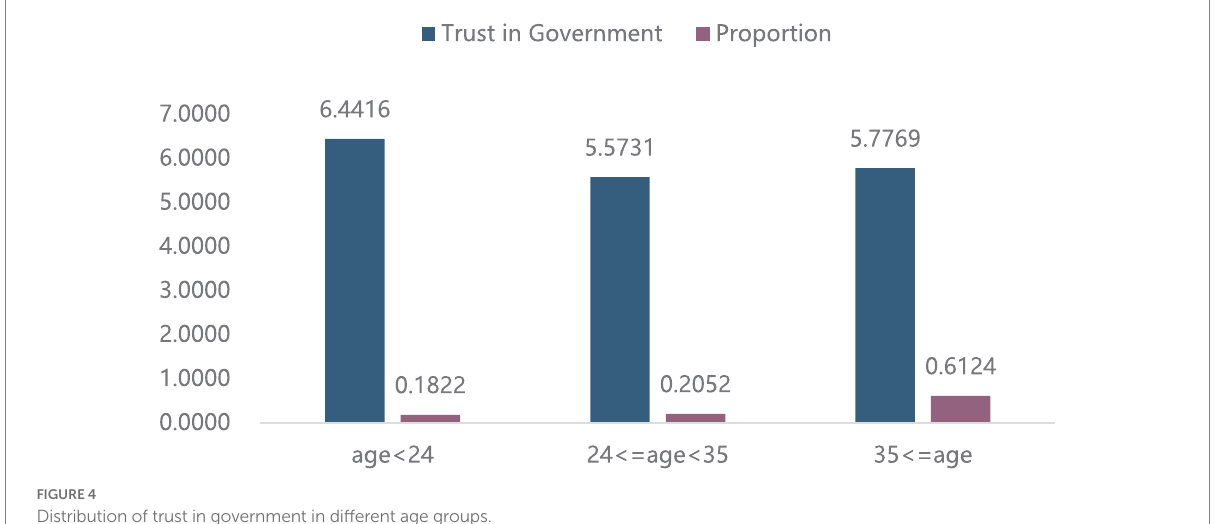
FIGURE 4 Distribution of trust in government in different age